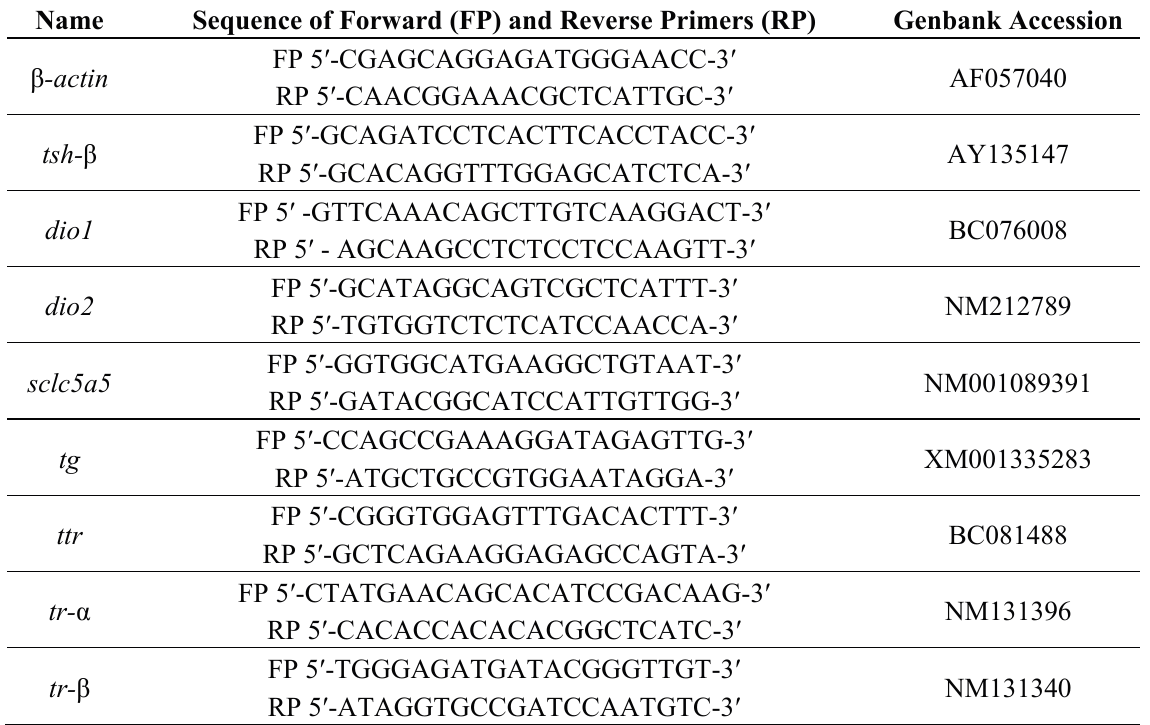
Table 1. Primers used for the quantification of mRNA expression by qRT-PCR.